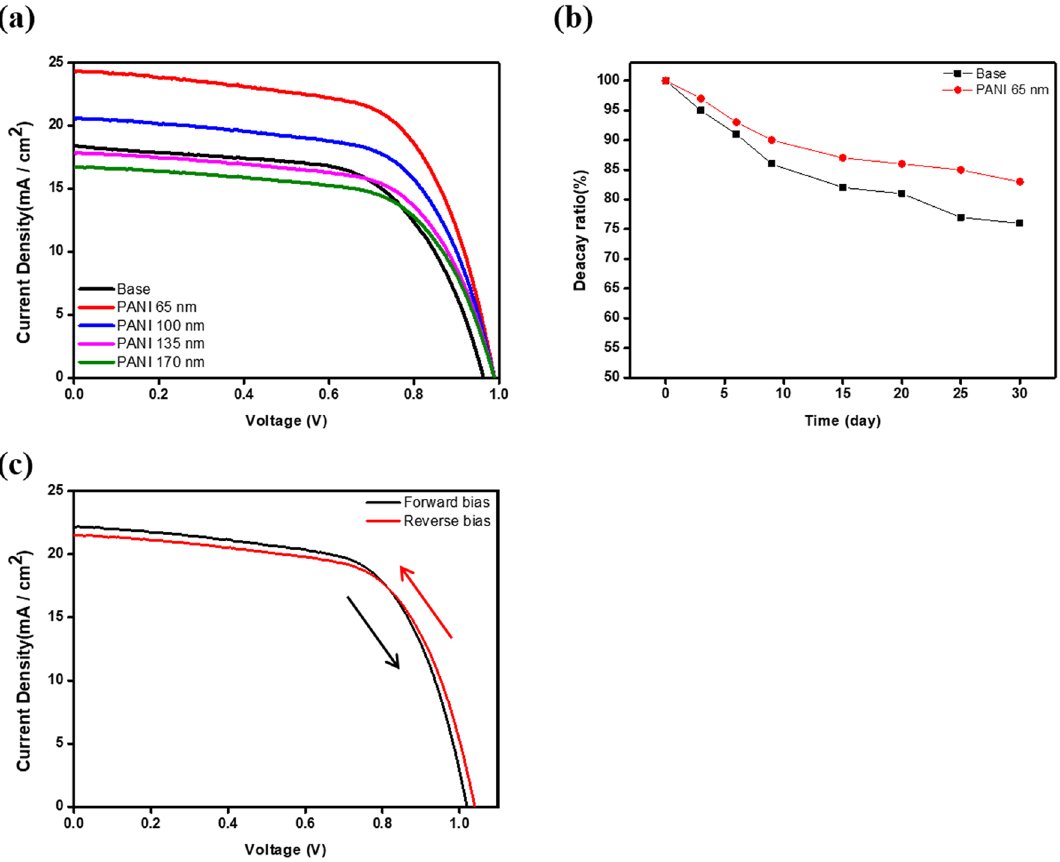
Figure 4. ( a ) The J–V curve and ( b ) the time-dependent evolution of efficiency ( c ) the J–V curve hysteresis of the perovskite solar cell with the PPL.